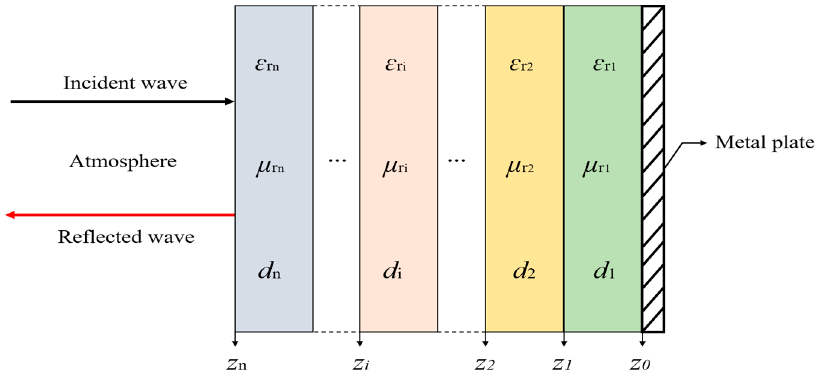
Figure 4. Schematic of a multilayer model with a normal incident wave.